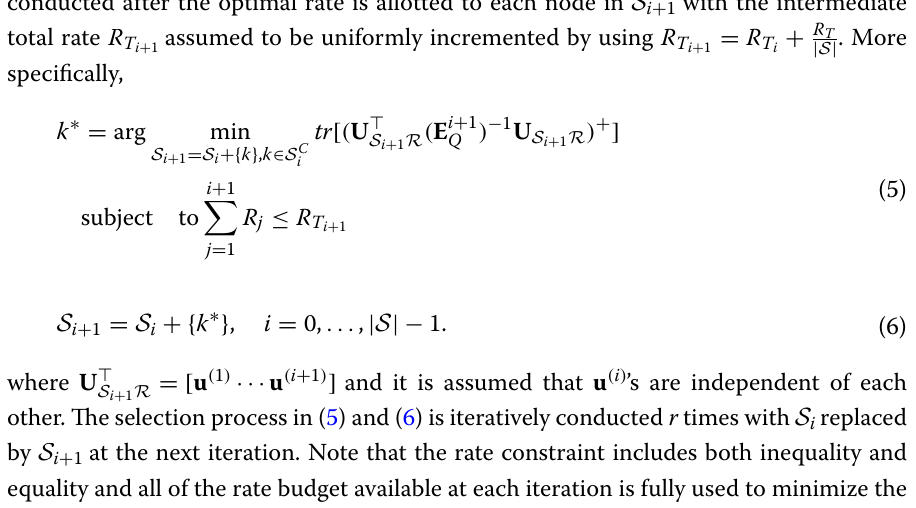
3 Method: sampling set selection